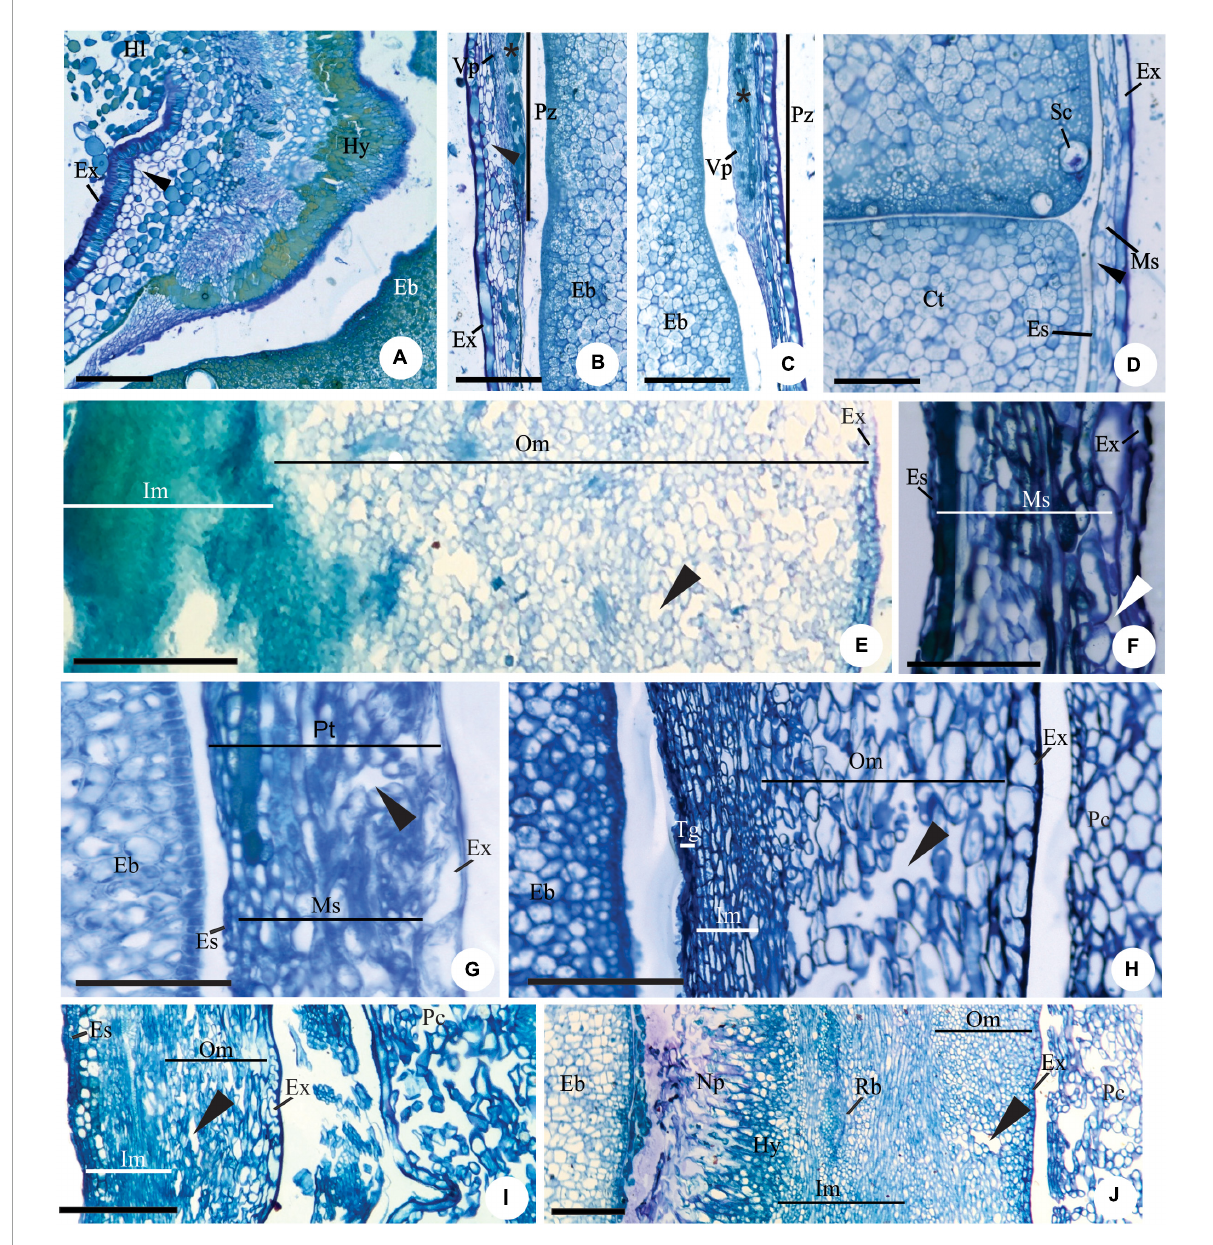
FIGURE3 Details of transversal (B–D,J) and longitudinal (A,E–I) sections showing the seed-coat in the immature (E–J) and mature seed (A–D) of Myrcianthes pungens (A–D) , Eugenia myrcianthes (E) , E. longipedunculata (F) , E. uniflora (G) , E. pyriformis (H) , E. involucrata (I) and E. gracillima (J) . (A) Hilar region evidencing hypostase with cells of phenolic content and exotesta constituted by macroesclereids (note the aerenchymatic mesotesta). (B–D) Seed-coat in perichalaza [pre-raphe – (B) and anti-raphe – (C)] , and in the testa (D) , respectively. Note the thick-walled tabular obliquely elongated exotestal cells, the crushed aerenchymatous mesotesta and the cells of phenolic content in the perichalaza (*). (E) Seed-coat in pachychalaza. Note the thin-walled tabular obliquely elongated exotestal cells, the multiplicative mesotesta (outer aerenchymatic), inner and endotesta cells with phenolic content. (F,G) Seed-coat in testa and pachychalaza. Note the thin-walled obliquely elongated tabular exotestal cells, the aerenchymatic mesotesta and endotesta crushing. (H,I) Seed-coat in testa. Note the obliquely elongated exotestal cells and the aerenchymatic outer mesotesta. (J) Seed-coat in rapheal region. Note the remains of the nucellus, the hypostase and the rapheal vascular bundle. Ct, cotyledonous; Eb, embryo; Es, endotesta; Ex, exotesta; Hl, hilum; Hy, hypostase; Im, inner mesotesta; Ms, mesotesta; Np, nucellus proliferation; Om, outer mesotesta; Pc, pericarp; Ph, perichalaza; Pt, pachychalazal integument; Rb, rapheal vascular bundle; Sc, secretory cavity; Ts, testa; Vp, pachychalazal vascular bundle; (cid:73) , intercellular space. Scale bars = 50 µ m (D,F–H) , 100 µ m (B,C) , 200 µ m (A,I,J) , 500 µ m (E)